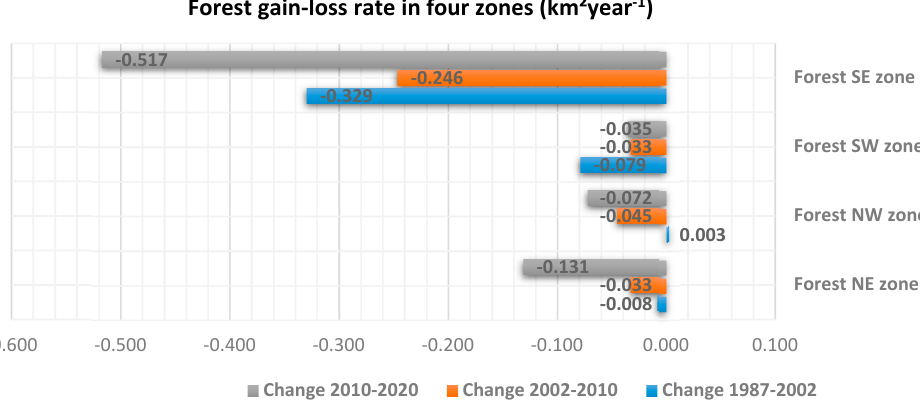
Figure 9. The forest gain–loss rate in four zones in the studied periods.